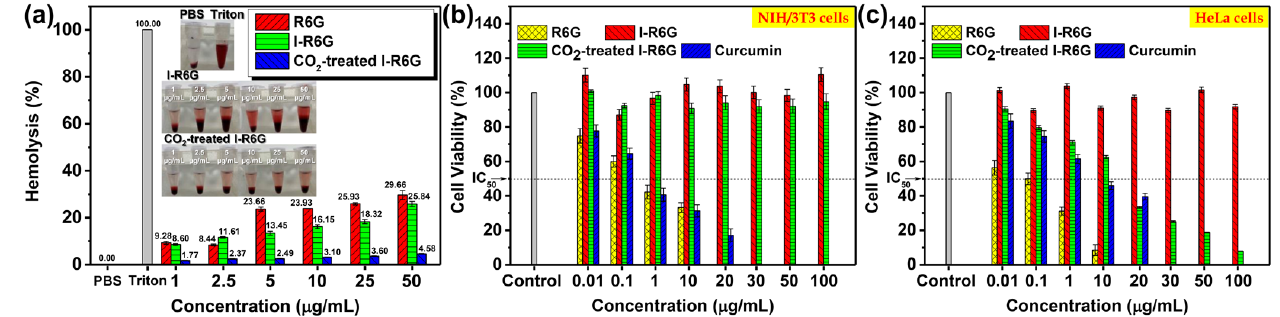
Figure 4. ( a ) In vitro haemolytic SRBC assays. The inset photographs show SRBCs after incubation with varying concentrations (1−50 μg/mL) of R6G and pristine or CO 2 -treated I-R6G for 4 h. In vitro cell viability assays of ( b ) NIH/3T3 and ( c ) HeLa cells after incubation with varying concentrations (0.01−100 μg/mL) of R6G and pristine or CO 2 -treated I-R6G for 24 h.